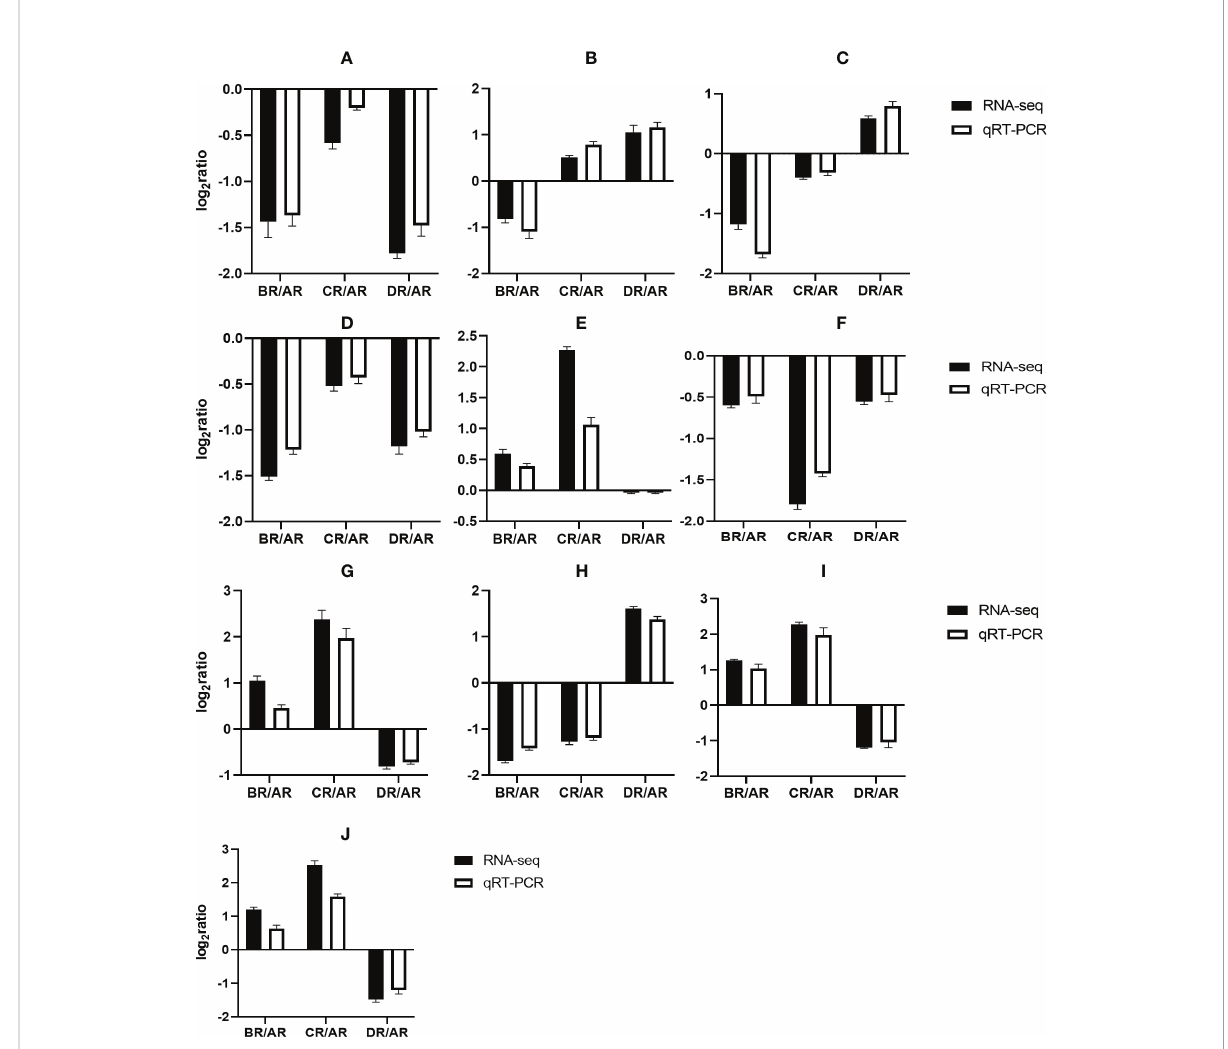
FIGURE 7 The expression pattern of DEGs involved in the inosine biosynthesis. (A , B) indicates genes encoding nucleoside-diphosphate kinase, (C, D) indicates genes encoding adenylate kinase, (E – G) indicates genes encoding nucleotidase, (H) indicates genes encoding purine nucleoside phosphorylase, (I, J) indicates genes encoding AMP deaminase. AR, BR, CR and DR represent four developmental stages of S. nudus : larve, one- quarter of adult, half of adult and adult,